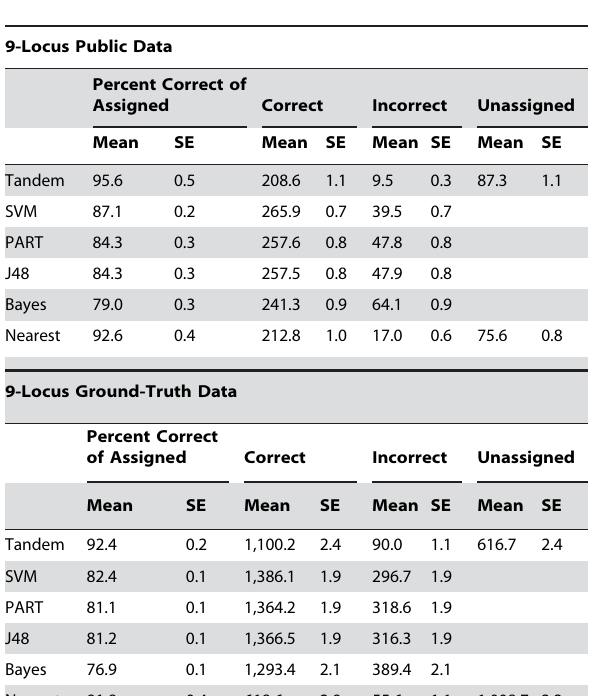
Table 3. Comparison of classifier performance across two data